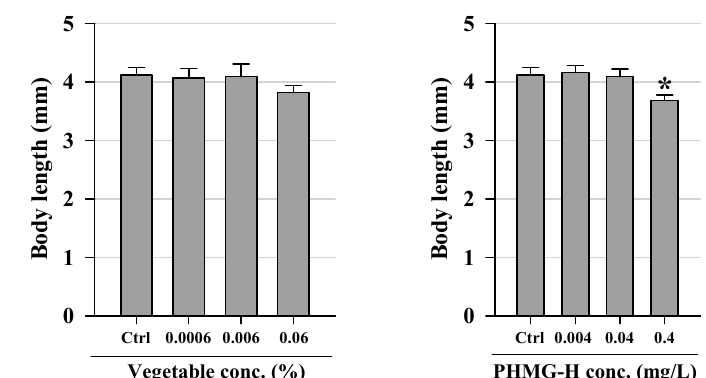
Figure 1. Acute lethality and developmental effects in zebrafish embryo/larvae after exposure to Vegetable HD and PHMG-H for 7 d. ( A ) Coagulated embryos (%), ( B ) malformation rate (%), ( C ) hatchability (%), ( D ) larval survival (%), and ( E ) body length of larvae (mm). The values are expressed as mean ± standard deviation of four replicates. Asterisk indicates significant difference from the control group ( p < 0.05).